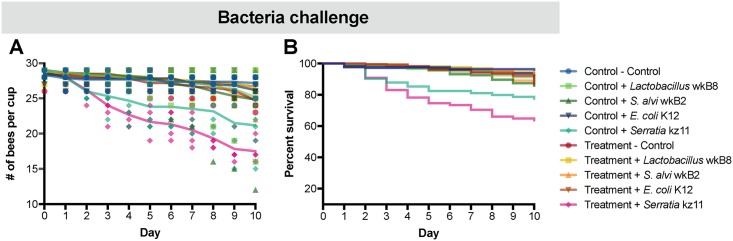
Bacterial challenge experiment.A) Number of control and tetracycline honeybees alive after exposure to different bacterial strains. Control bees were fed sterile sugar syrup for 5 d, and treatment bees were administered 450 ug/ml of tetracycline in sterile sugar syrup for 5 d, followed by exposure to i) Serratia kz11, ii) E. coli K-12, iii) S. alvi wkB2, iv) Lactobacillus sp. wkB8, or v) no bacteria. Five replicates were performed for each group. Survivorship was monitored and recorded each day for 10 d (S10 Data). B) Kaplan—Meier survival curve showing the percent survival of control and tetracycline-treated bees after bacteria exposure. The survival curve was created using GraphPad Prism. Statistical analyses were performed using the coxph model implemented in the “survival” package [30] in R (S9 Data).